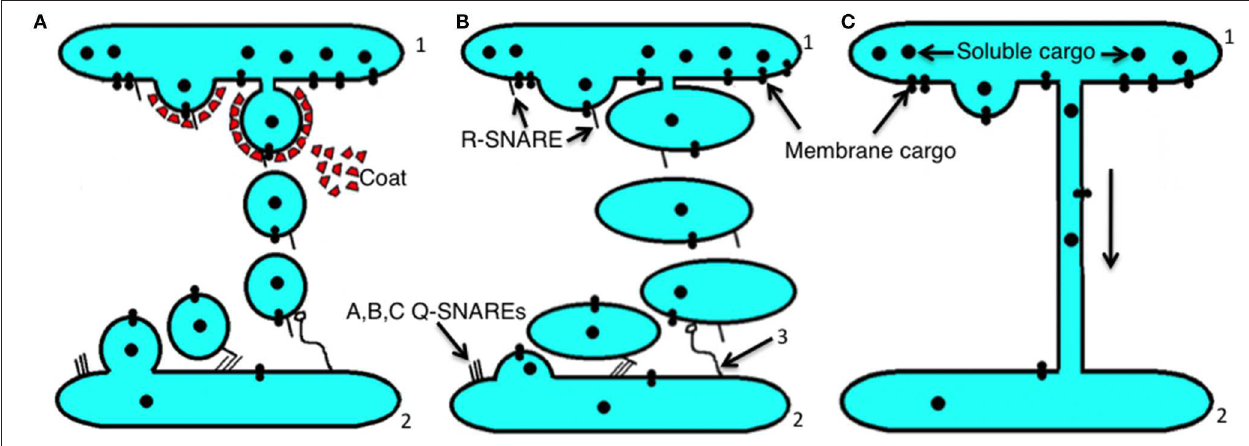
FIGURE 2 | Scheme showing the main principles of intracellular transport. (A) The dissociation (mainly vesicular) mode. Initially, membrane buds are formed on a proximal compartment (1) with the help of a protein coat, and then after fission and subsequent uncoating, coat-dependent vesicles move to a distal compartment (2) and are captured by a tethering system (3). Then using SNAREs, the vesicle fuses with the second compartment. (B) The progression mode. Initially a large membrane protrusion is formed from a proximal compartment (1), and it undergoes fission. Then this large carrier is captured by the tethering system (3), and with the help of SNAREs it undergoes fusion with a distal compartment (2). (C) The lateral diffusion mode of intracellular transport between a proximal compartment (1) and a distal compartment